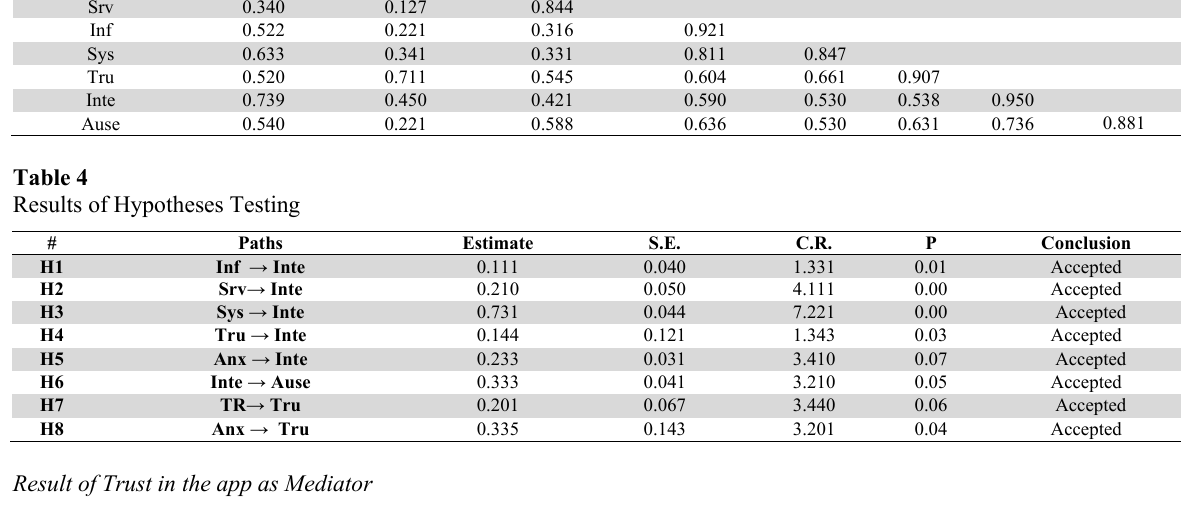
Result of Trust in the app as Mediator